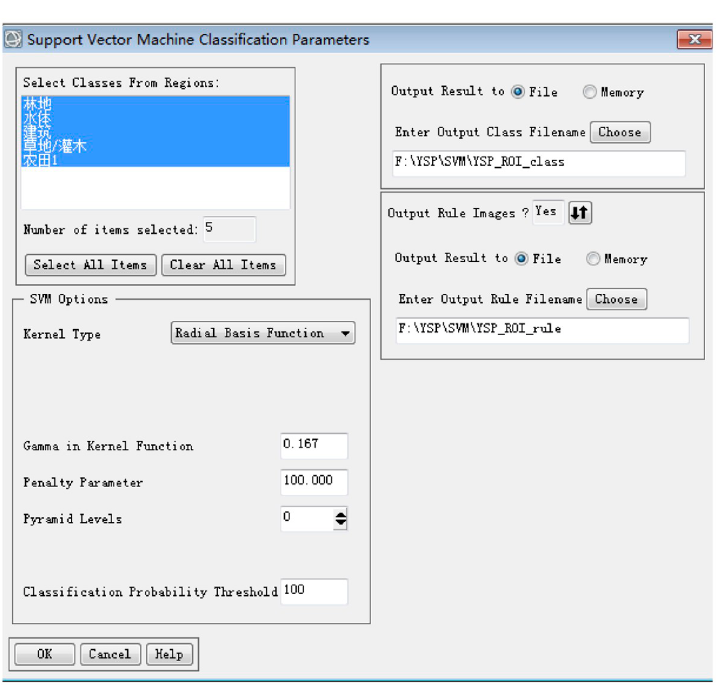
Fig 10. SVM parameter